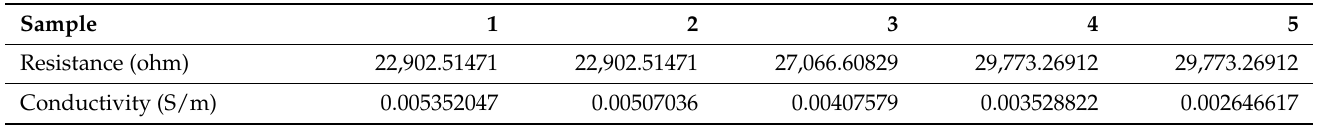
Table A1. Conductivity Data for Nylon 610 Nanocomposites with 0.5 wt% Graphite Nanosheets Treated at 200 ◦ C and − 1 bar.